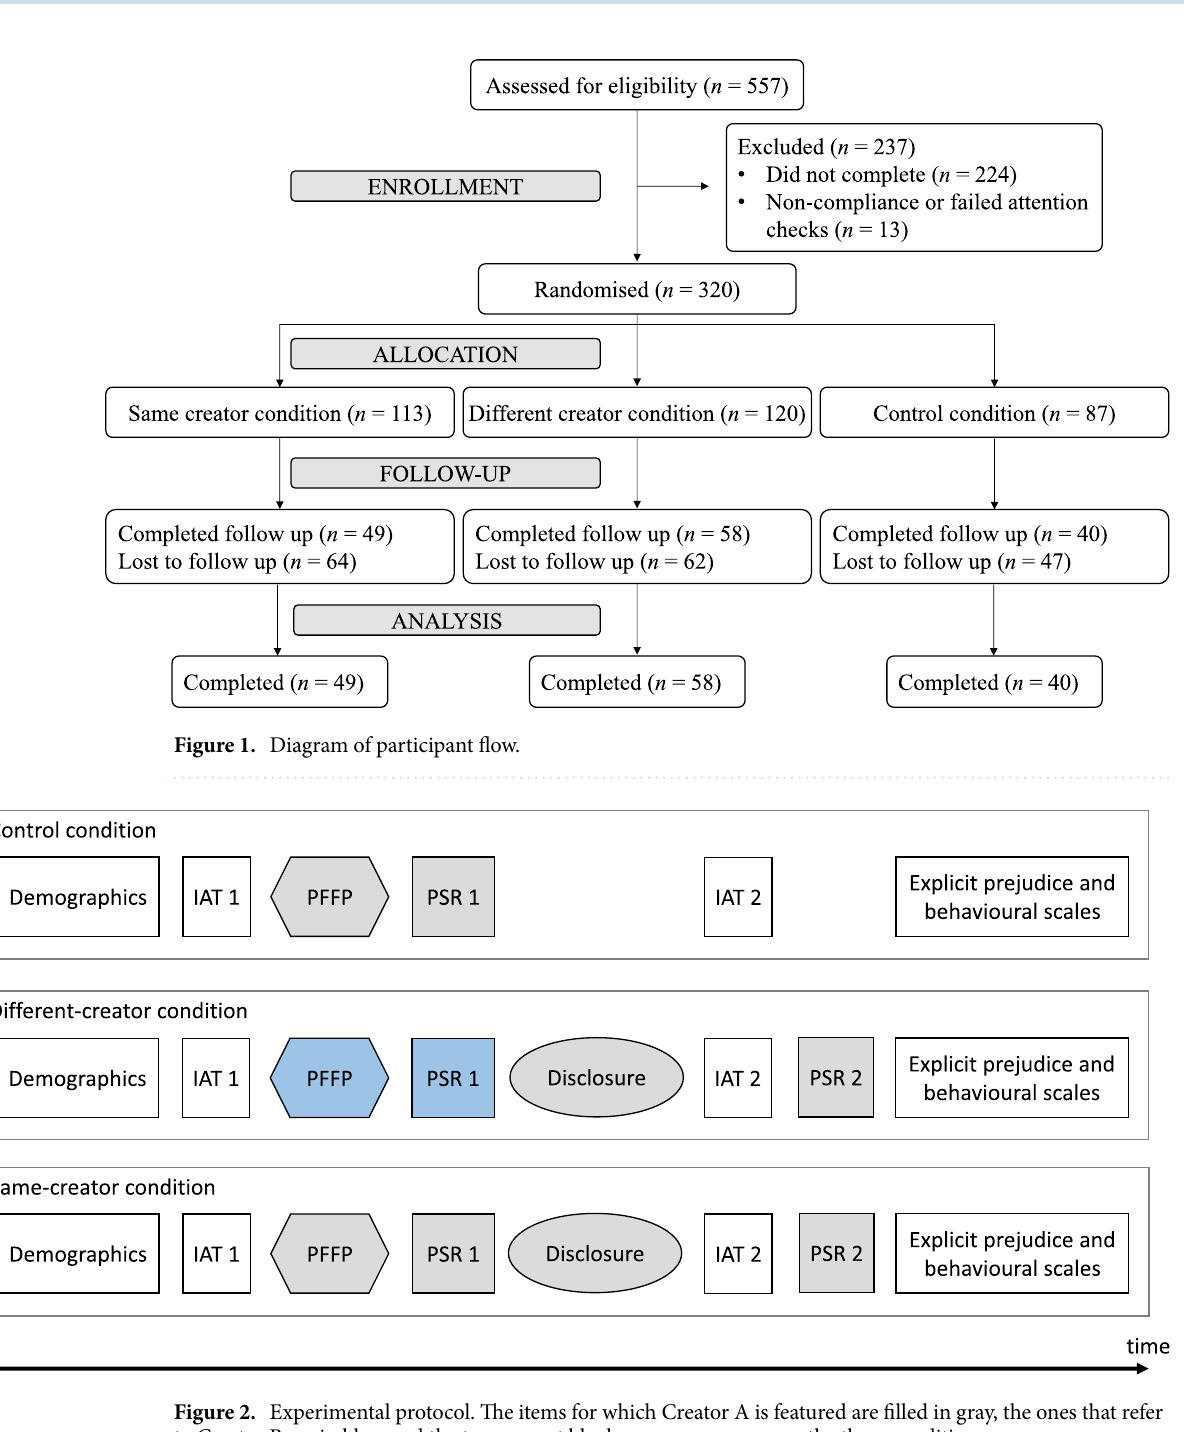
Figure 2. Experimental protocol. The items for which Creator A is featured are filled in gray, the ones that refer to Creator B are in blue, and the transparent blocks are common across the three